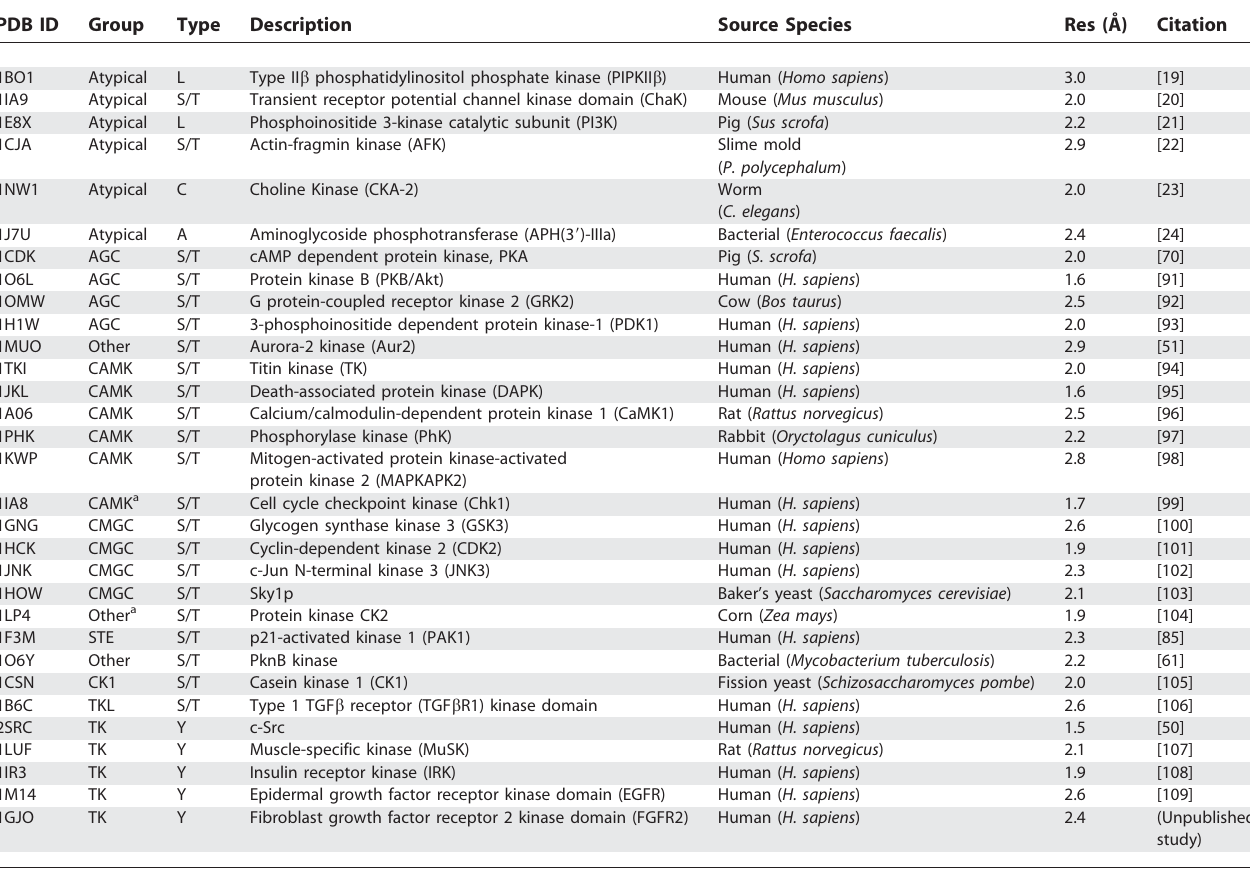
Figure 2. Views of Structural Representatives from Six Families in the Kinase-Like Superfamily Other Than the TPKs Structures are shown in an open-face view, and using the same conventions as used for PKA in Figure 1. ATP and metal ions are shown in mirror image where available in the structure. Similar to Figure 1, secondary structural elements are colored according to their conservation status in the overall superfamily as follows: yellow, elements are part of the ‘‘ universal core ’’ seen in all kinases in the superfamily; orange, elements are present in more than two, but not all, of the kinases in the superfamily; red, elements shared between only two families; purple, elements seen only in this family, but inserted within in the portion of the chain forming the universal core; blue, elements seen only in this family, and connected to the N- or C-terminal ends of the universal core. Secondary structural elements are labeled according to the standard conventions for the individual structure. As in Figure 1, the glycine-rich loop is rendered in green and the loop forming the linker region is rendered in red. For clarity, the conserved residues shown in Figure 1 are not rendered in these structures, though in most cases they are similar. Structures shown are as follows: (A) aminoglycoside phosphotransferase (APH(3 9 )-IIIa [24]); (B) CK (CKA-2 [23]); (C) ChaK [20]; (D) PI3K [21]; (E) AFK [22]; and (F) PIPKII b [19]. Molecular renderings in this figure were created with MOLSCRIPT [90]. DOI: